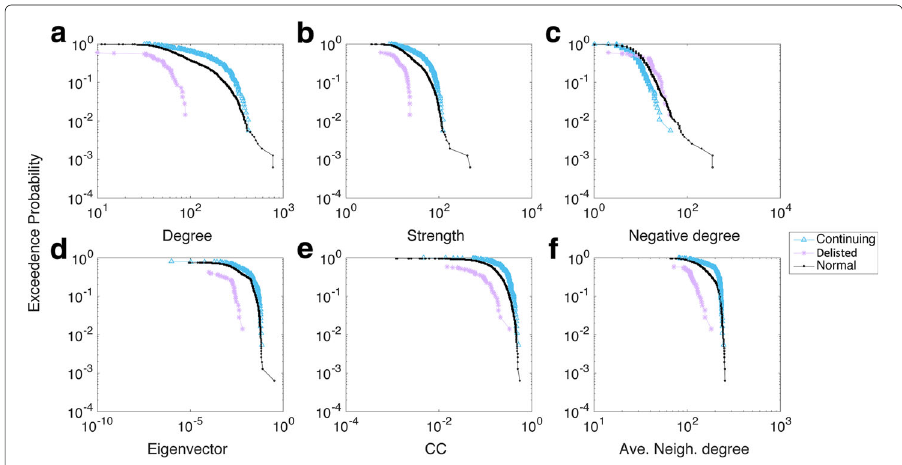
Fig. 4 Distribution of the six network measures in 1993-1994. a Degree; b Strength; c Negative degree; d Eigenvector; e CC; f Ave. Neigh.